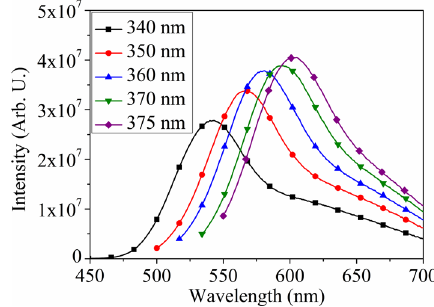
Fig. 8 Excitation-dependent FL spectrum of CdTe QDs for the sample S